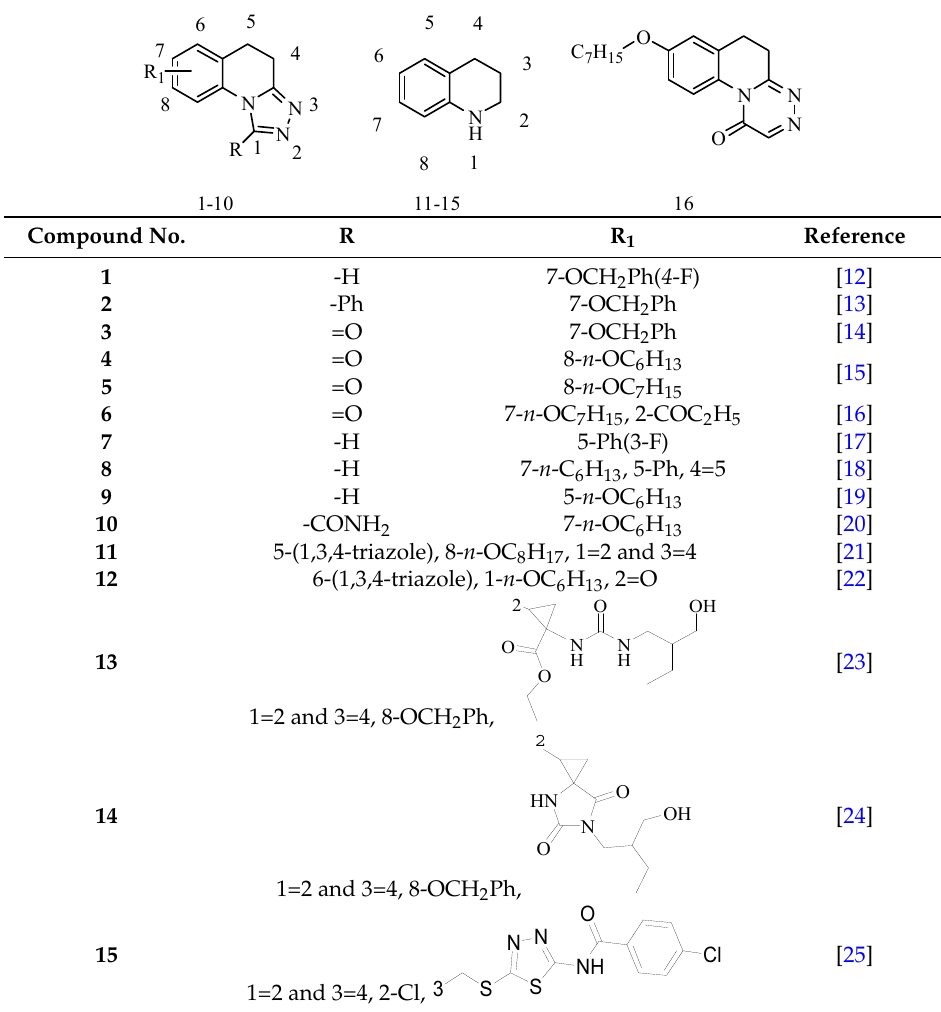
Table 1. Quinoline anticonvulsant compounds.